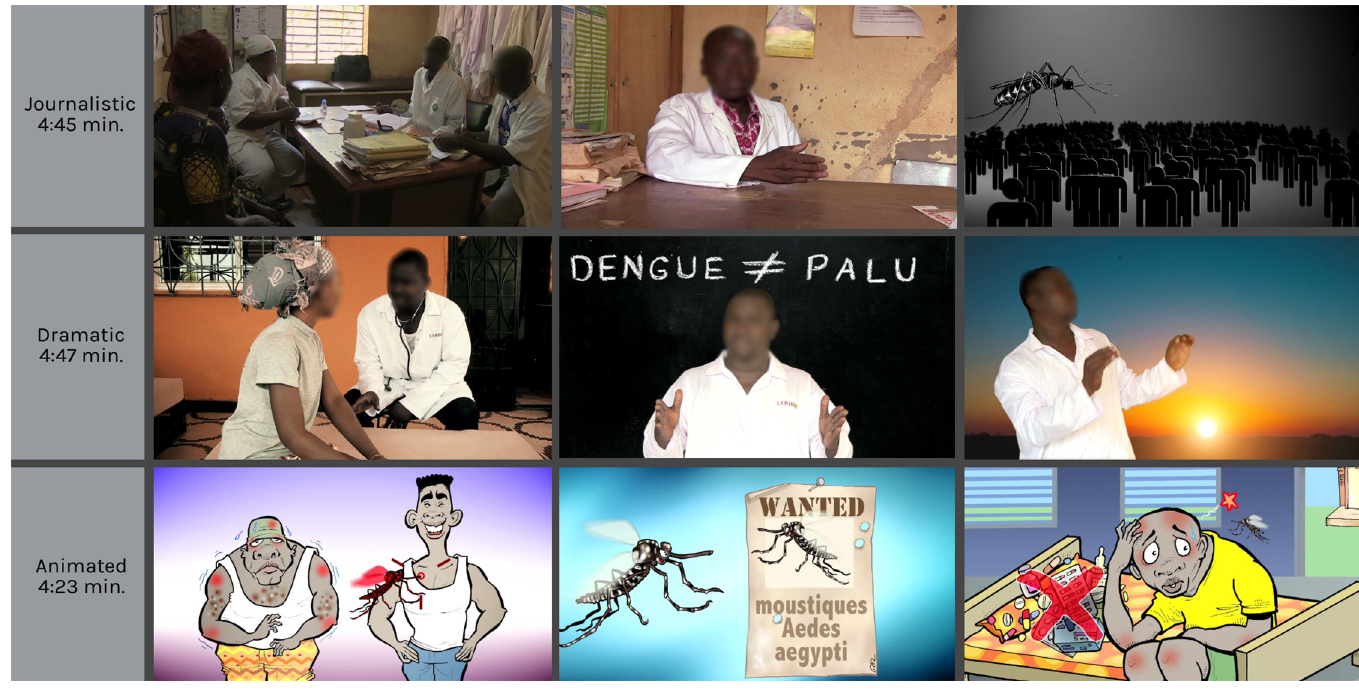
Fig 1. Overview of the narrative genres of the